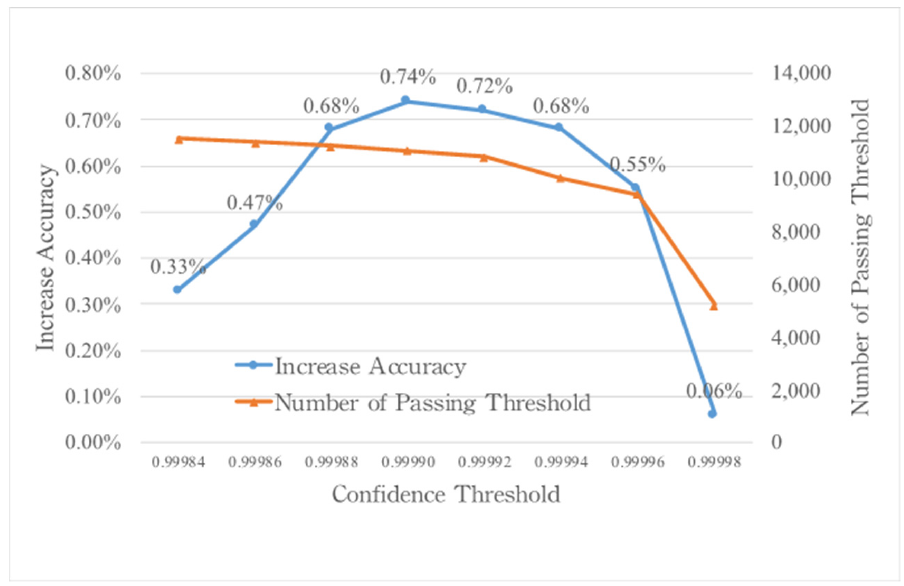
Figure 11. The performance of different GRU model’s confidence thresholds.